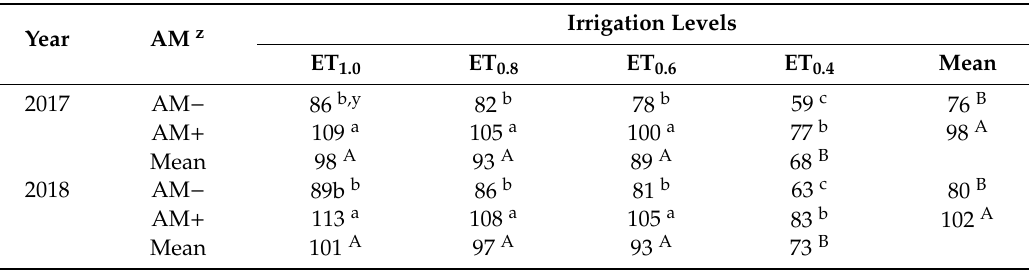
Table 3. Water use e ffi ciency (WUE - kg ha − 1 mm − 1 ) of eggplant subjected to varying water stress and AM inoculation.